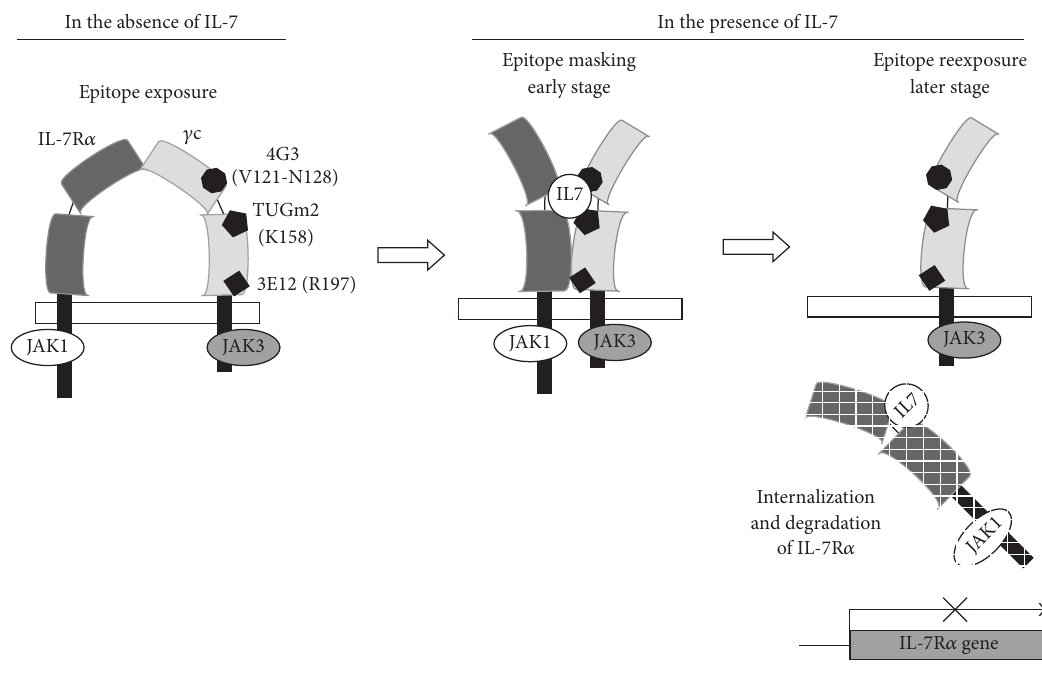
Figure 5: Model of IL-7R 𝛼 / 𝛾 c receptor core conformational states in the absence or presence of IL-7. This model builds on the concept that binding affinity between IL-7R 𝛼 and 𝛾 c is present on the cell surface as inactive heterodimers. In the absence of IL-7, ligand independent association of IL-7R 𝛼 and 𝛾 c would keep JAK1 and JAK3 separated by a large distance to prevent activation. Once IL-7 binds to IL-7R 𝛼 / 𝛾 c receptor core, the receptors undergo a conformational change, locating the two intracellular domains and activating the signal transduction. At a later stage of IL-7 signaling, IL-7R 𝛼 is internalized, degraded, and transcriptionally terminated, in which the epitopes masked by IL- 7/IL-7R 𝛼 are reexposed in free 𝛾